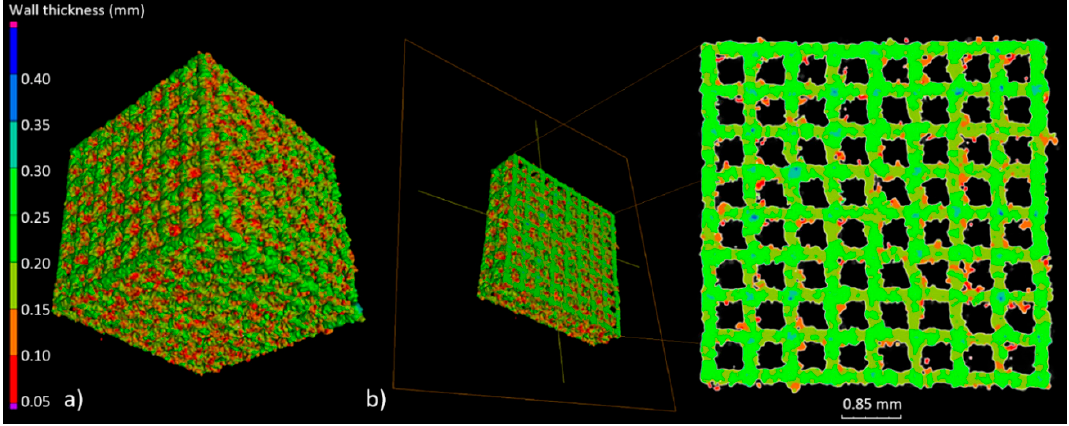
Figure 6. ( a ) Example of wall thickness analysis (‘A3 type’ specimen); ( b ) cross-section showing the thickness changes of the struts in the A3 specimen.